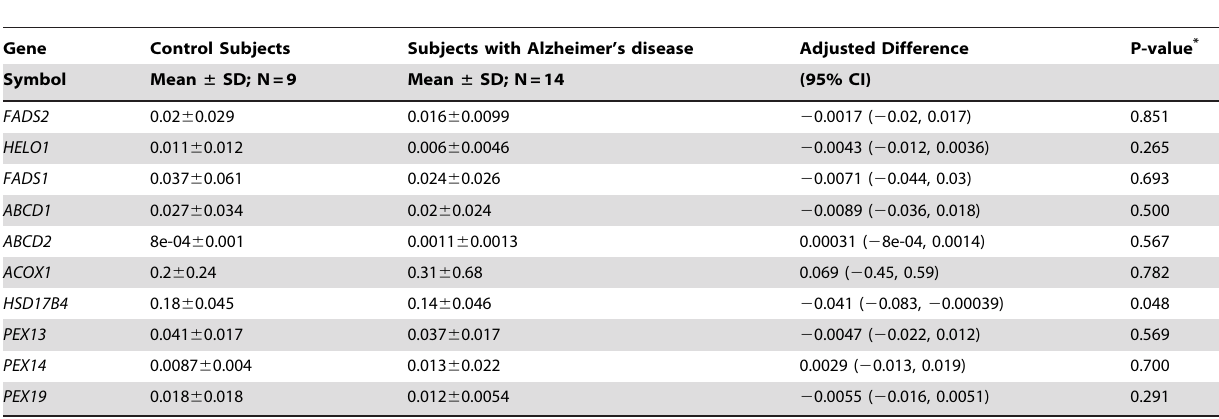
Abbreviations: CI, confidence interval. *P-values for differences between means were computed by linear regression analysis after adjustment for age, gender, and RNA integrity number. Hydroxysteroid (17-beta) dehydrogenase 4, HSD17B4 ; for other abbreviations see Text S1.